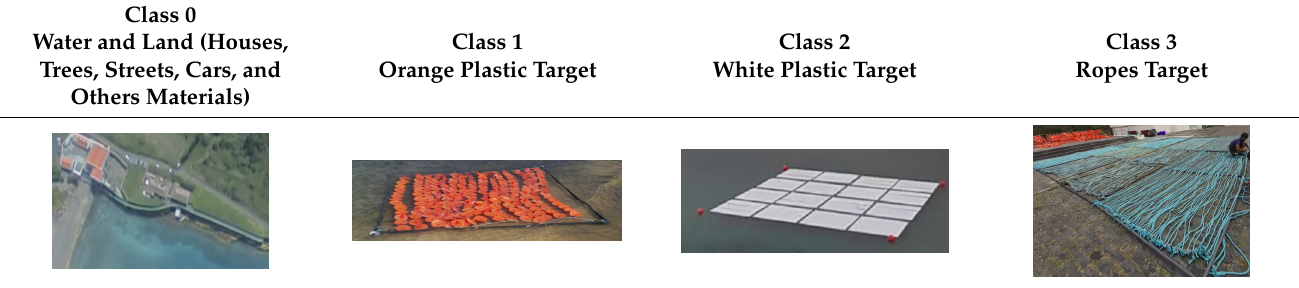
Table 3. Targets used during the dataset collection and their division between the classes. Class 0 Water and Land (Houses, Trees, Streets, Cars, and Others